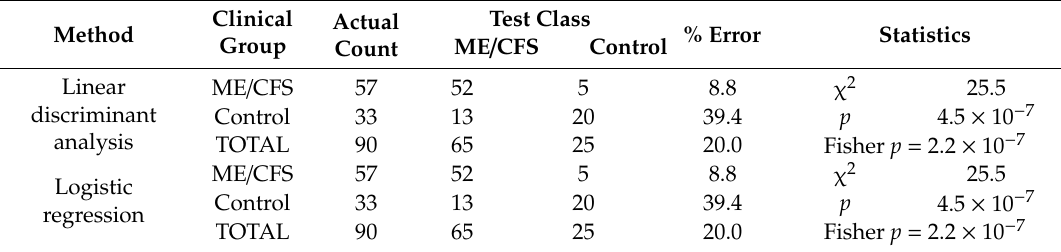
Table 1. “Confusion matrix” analysis of lymphocyte death rate after 48 h in culture